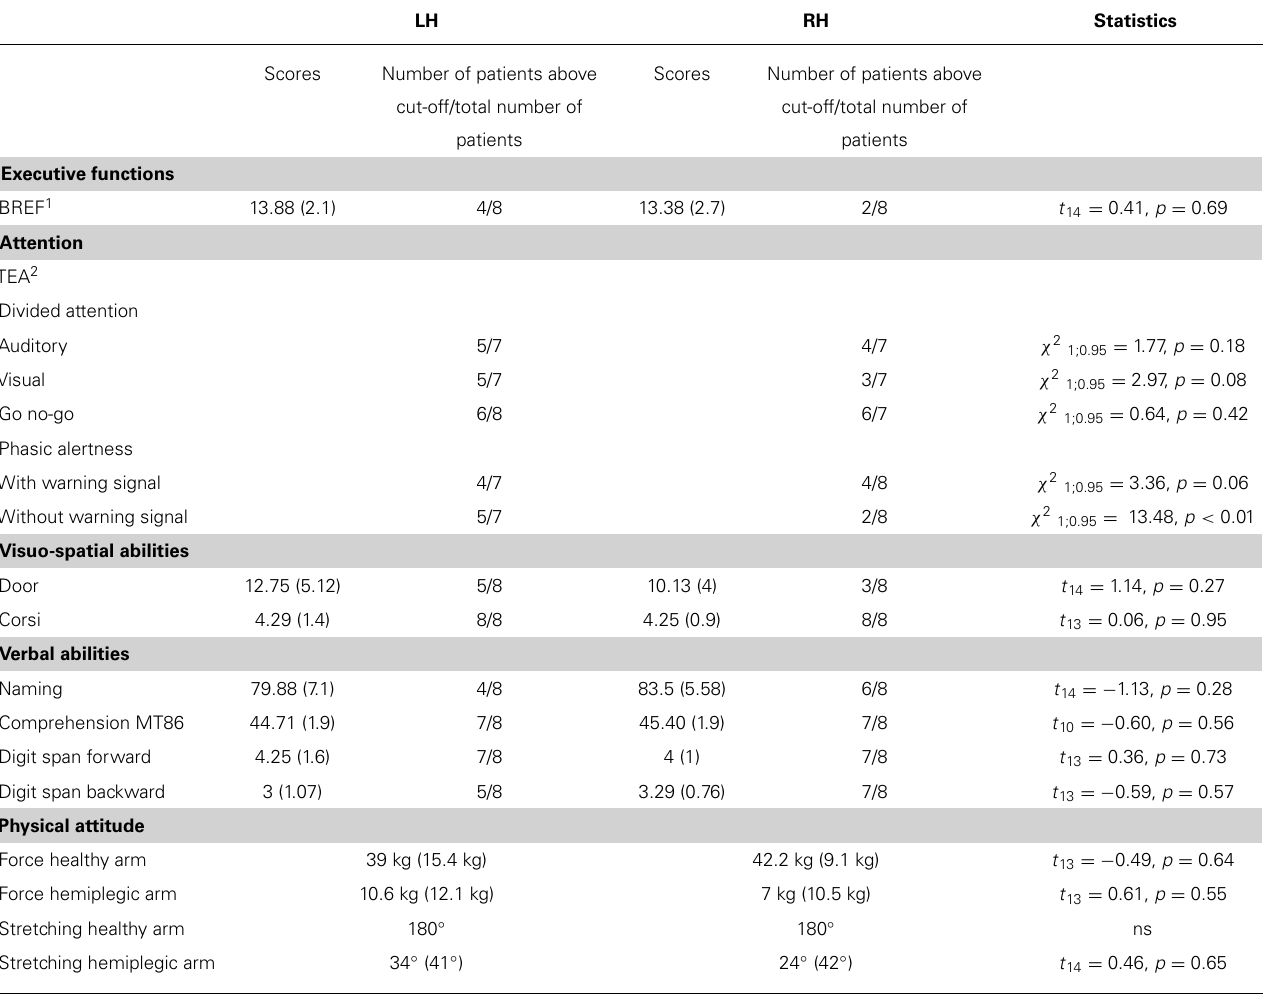
Table 2 | Cognitive and physical scores for the two patients’ group (the number of participants included in the analysis varied depending on the test due to failure of the evaluation in some cases). LH RH Statistics Scores Number of patients above Scores Number of patients above cut-off/total number of cut-off/total number of patients